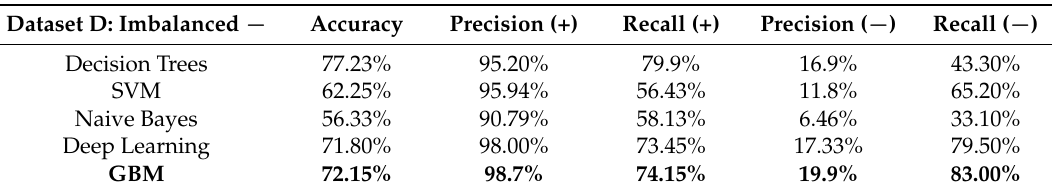
Table 9. Performance of GBM against other benchmarking methods for Dataset D negative imbalanced without any measures for the class imbalance problem.